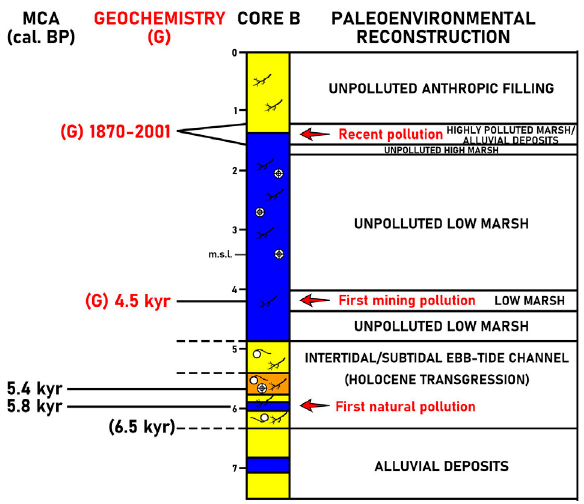
Fig. 6. – Paleoenvironmental evolution of core B. MCA: mean calibrated